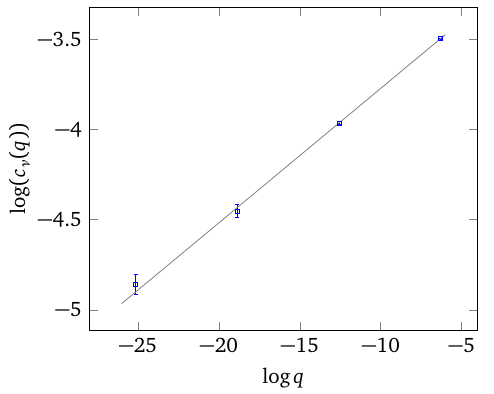
Figure 13: c ν as a function of q and the best fit line, for H = − 2 / 3.